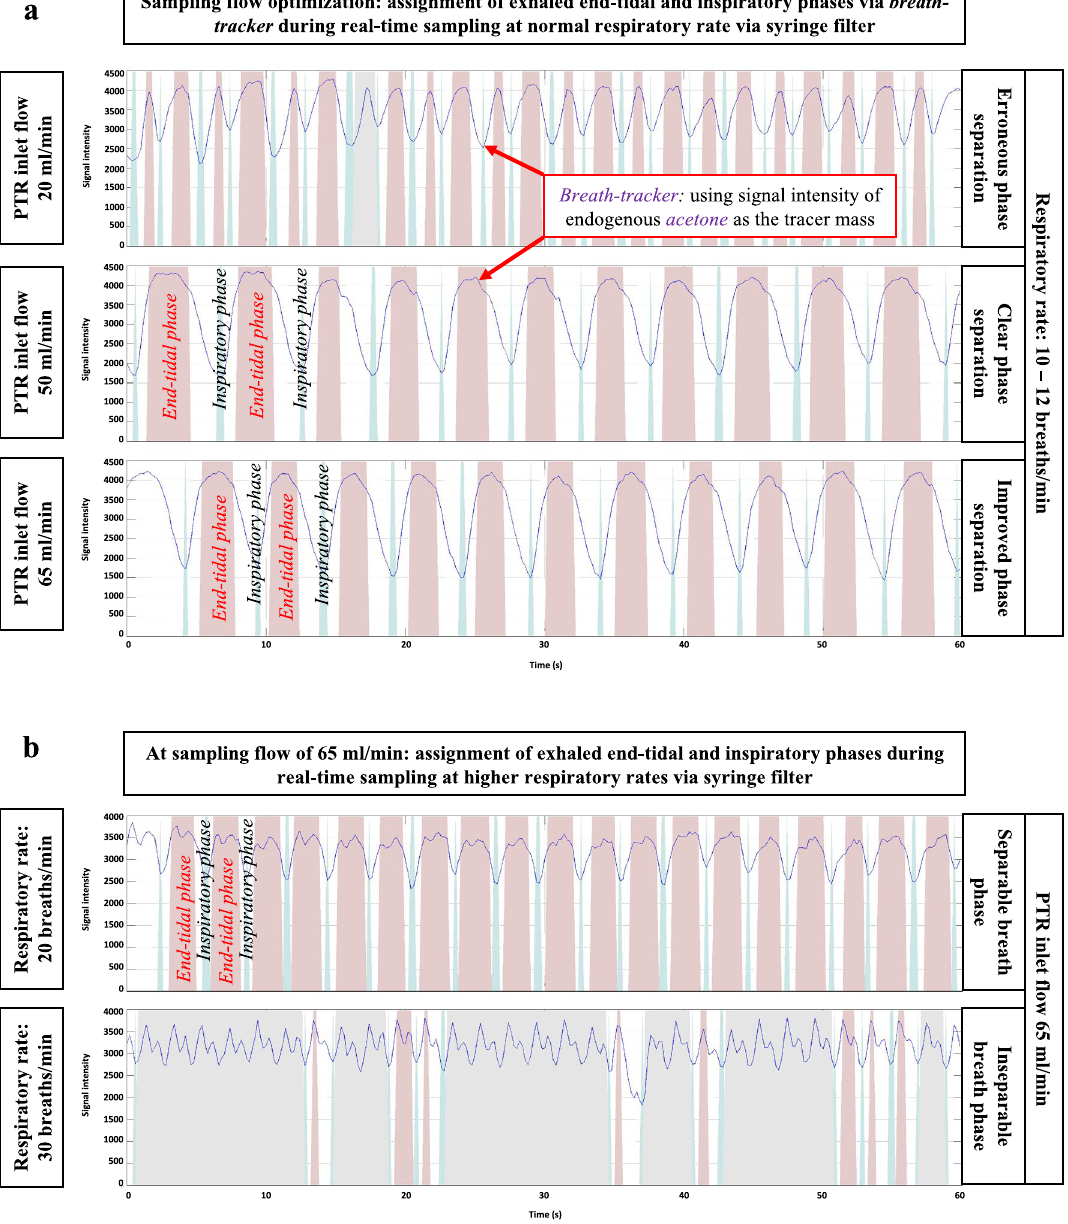
Figure 3. Effects of PTR sampling flow on breath-resolved assignment of expiratory and inspiratory phases via syringe-filters under normal ( a ) and higher ( b ) respiratory rates: Here, breath tracker plots are presented under various sampling conditions. In all breath-tracker plots, Y-axis represent signal intensity of acetone (an endogenous and blood-borne VOCs) and all X-axis represent time in s. Red colour represents exhaled alveolar/ end-tidal phase and blue colour represents inspiratory (room-air) phase. ( a ) Sampling flows of 20, 50 and 65 mL/min were applied for sampling under respiratory rate of 10–12 breaths/min. ( b ) Sampling flow of 65 mL/ min was applied for sampling high respiratory rates of 20–30